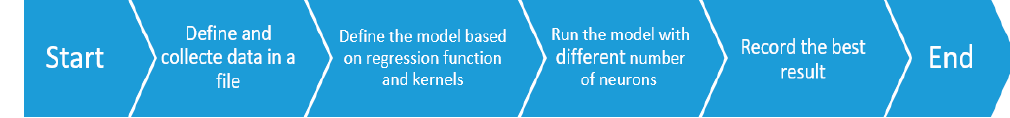
Figure 4. Process of the proposed model.